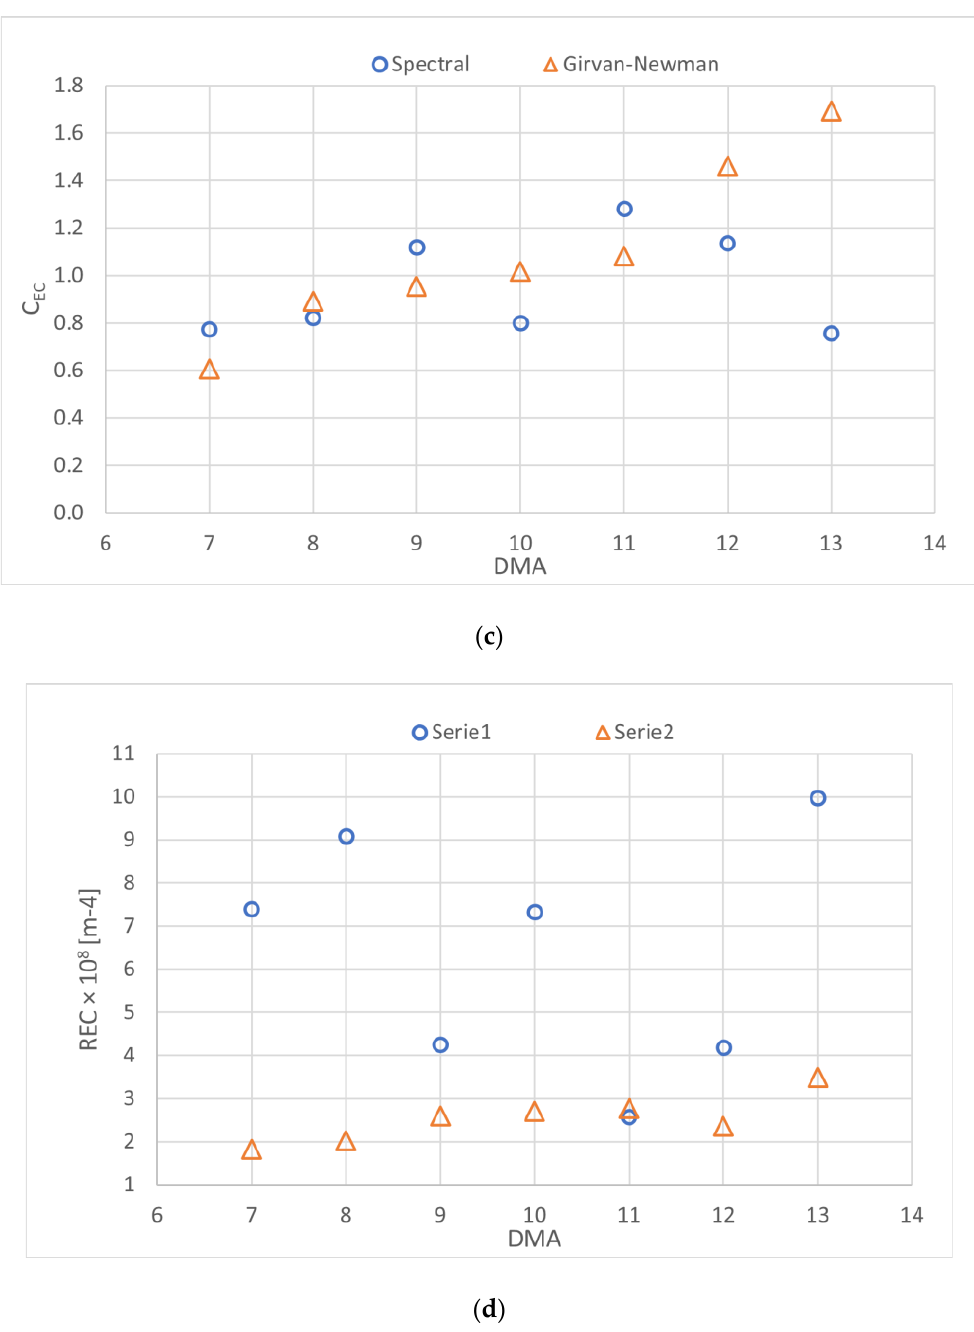
Figure 3. ( a ) Number of DMA-balance index relation for clustering algorithms; ( b ) number of DMA- number of edge-cuts relation for clustering algorithms; ( c ) number of DMA-conductance relation for clustering algorithms; ( d ) number of DMA-resistance relation for clustering algorithms.